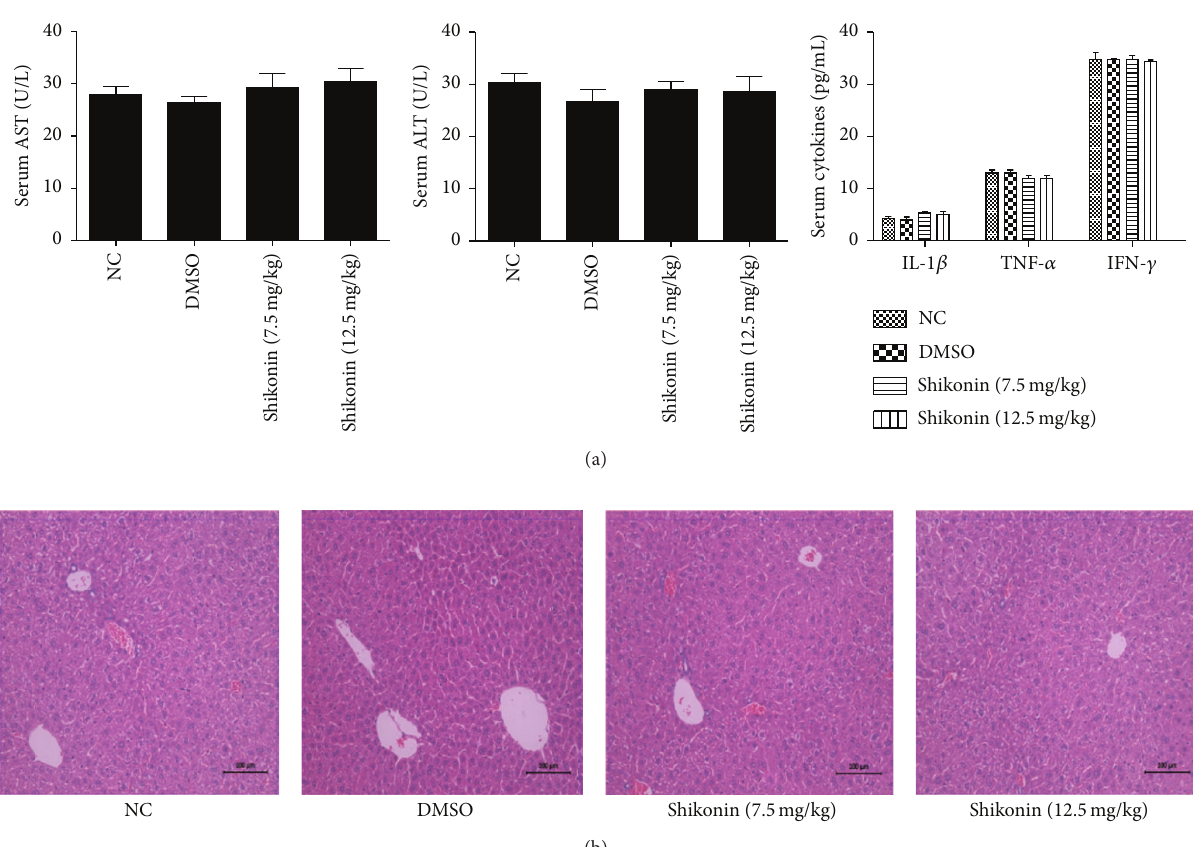
Figure 1: Effects of 2% DMSO and shikonin on the liver function and pathology of healthy mice. (a) The levels of serum ALT and AST in the four groups did not differ. Data are given as means ± SD ( 𝑛 = 4 , 𝑃 > 0.05 ). The serum levels of TNF- 𝛼 , IL-1 𝛽 , and IFN- 𝛾 of four groups were evaluated in each group with ELISAs ( 𝑛 = 4 , 𝑃 > 0.05 ). (b) Representative hematoxylin-and-eosin-stained sections of the liver. Original magnification, ×